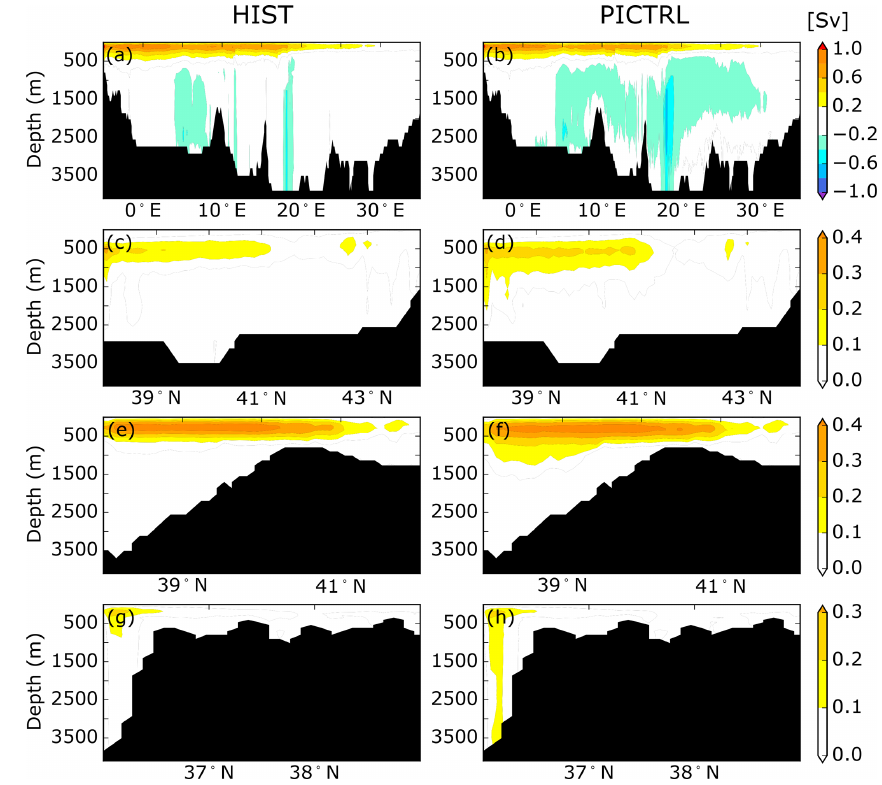
Figure 6. (a, b) Zonal overturning stream function (ZOF) integrated from north to south and shown as a longitude–depth section for the whole Mediterranean Sea, for the HIST and PICTRL simulations (from top to bottom), respectively. Other panels show meridional overturning stream function (MOF) shown as a latitude–depth section, integrated west/east for the Gulf of Lion ( c, d , longitudinal extent: 4.5–8 ◦ E), the Adriatic/Ionian Sea ( e, f , 12–21 ◦ E) and the Aegean Sea ( g, h , 24–28 ◦ E) averaged over the entire simulation for HIST and over the last 30 years of simulation for